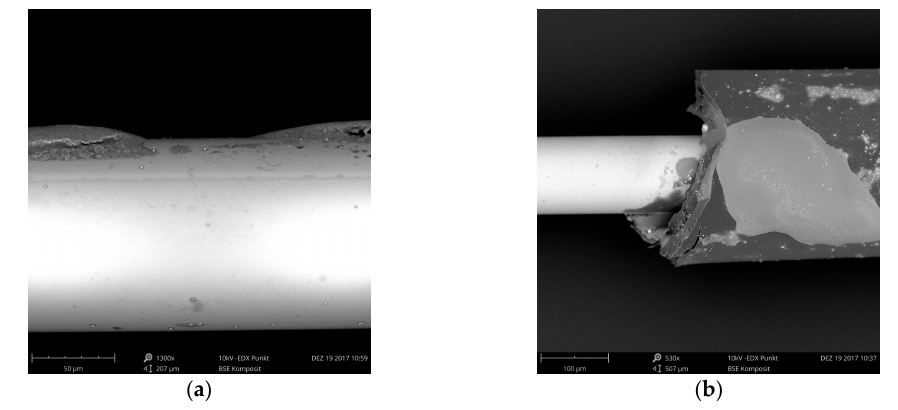
Figure 7. Scanning electron micrograph of the etched glass surface of the fiber: ( a ) The edge waveguide with the surface Bragg grating can be very well recognized (25 µm from the upper edge of the visible 125 µm fiber diameter); ( b ) shown is the transition zone between the stripped fiberglass (125 µm outer diameter) and the polyimide coating (175 µm), which appears excessively large due to swelling during processing.